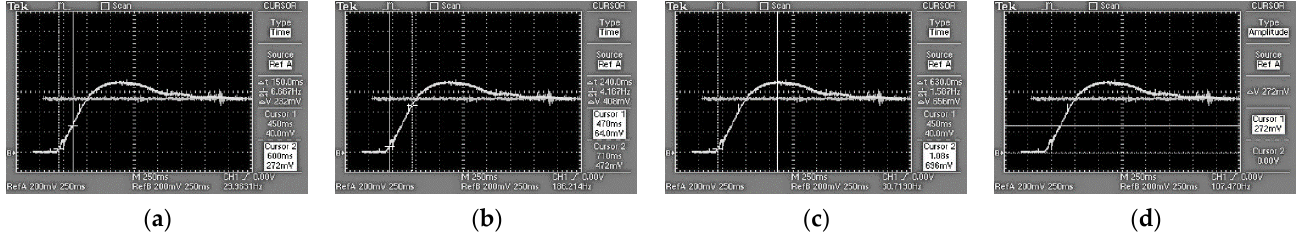
Figure 14. Transient behavior with Fuzzy-PI Controller (Experimental). ( a ) Delay Time, ( b ) Rise Time, ( c ) Peak Time, ( d ) Settle Time.